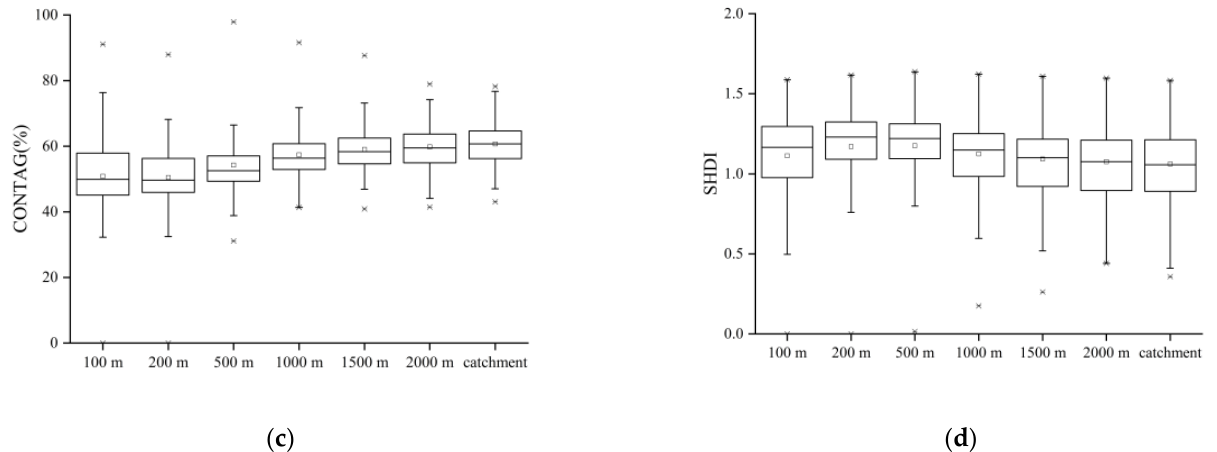
Figure 3. Land use metrics representing the spatial configurations of the riparian buffer widths and catchment:( a ) PD means the number of patches per unit area (number per 100 ha); ( b ) LSI provides a standardized measure of total edge or edge density that adjusts for the size of the landscape; ( c ) CONTAG describes the degree of agglomeration or spreading trend of different patch types in the landscape; ( d ) SHDI equals minus the sum, across all patch types, of the proportional abundance of each patch type multiplied by that proportion.